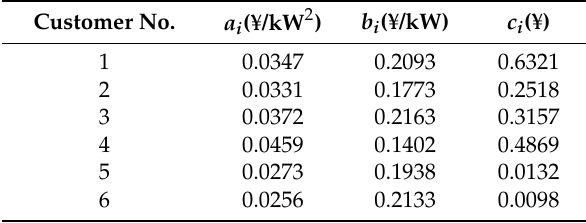
Table 2. Parameters of six customer cost functions. Customer No.